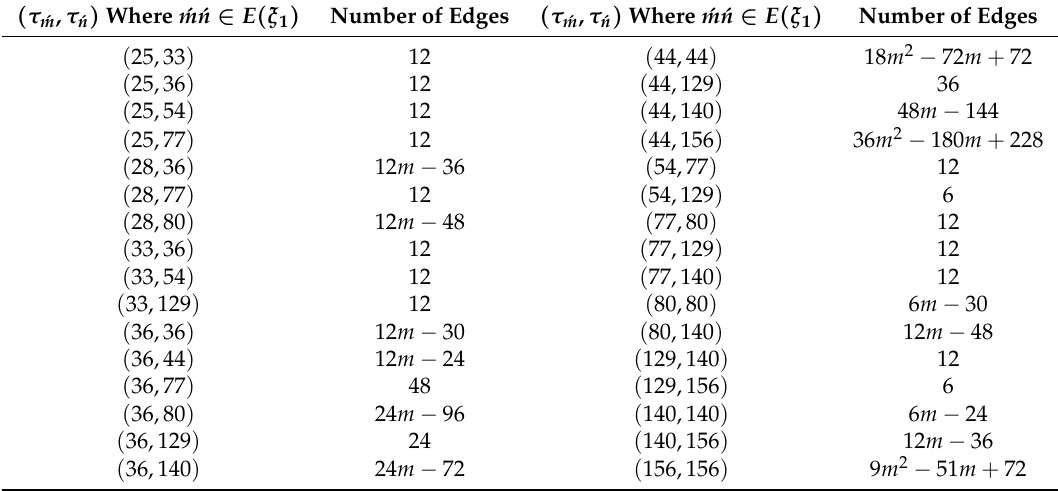
Table 2. Edge partition of the third type of hex-derived network HDN 3 ( m ) based on sum of degrees of end vertices of each